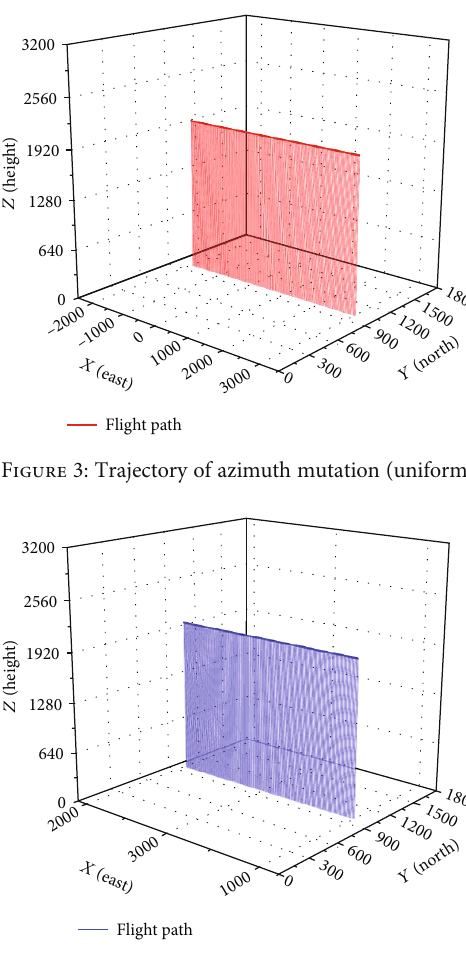
Figure 4: Trajectory without azimuth mutation